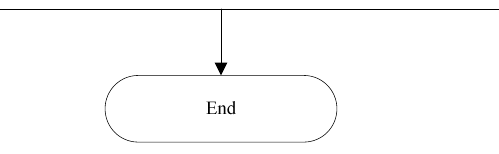
Figure 4. Solution flow of the proposed model.